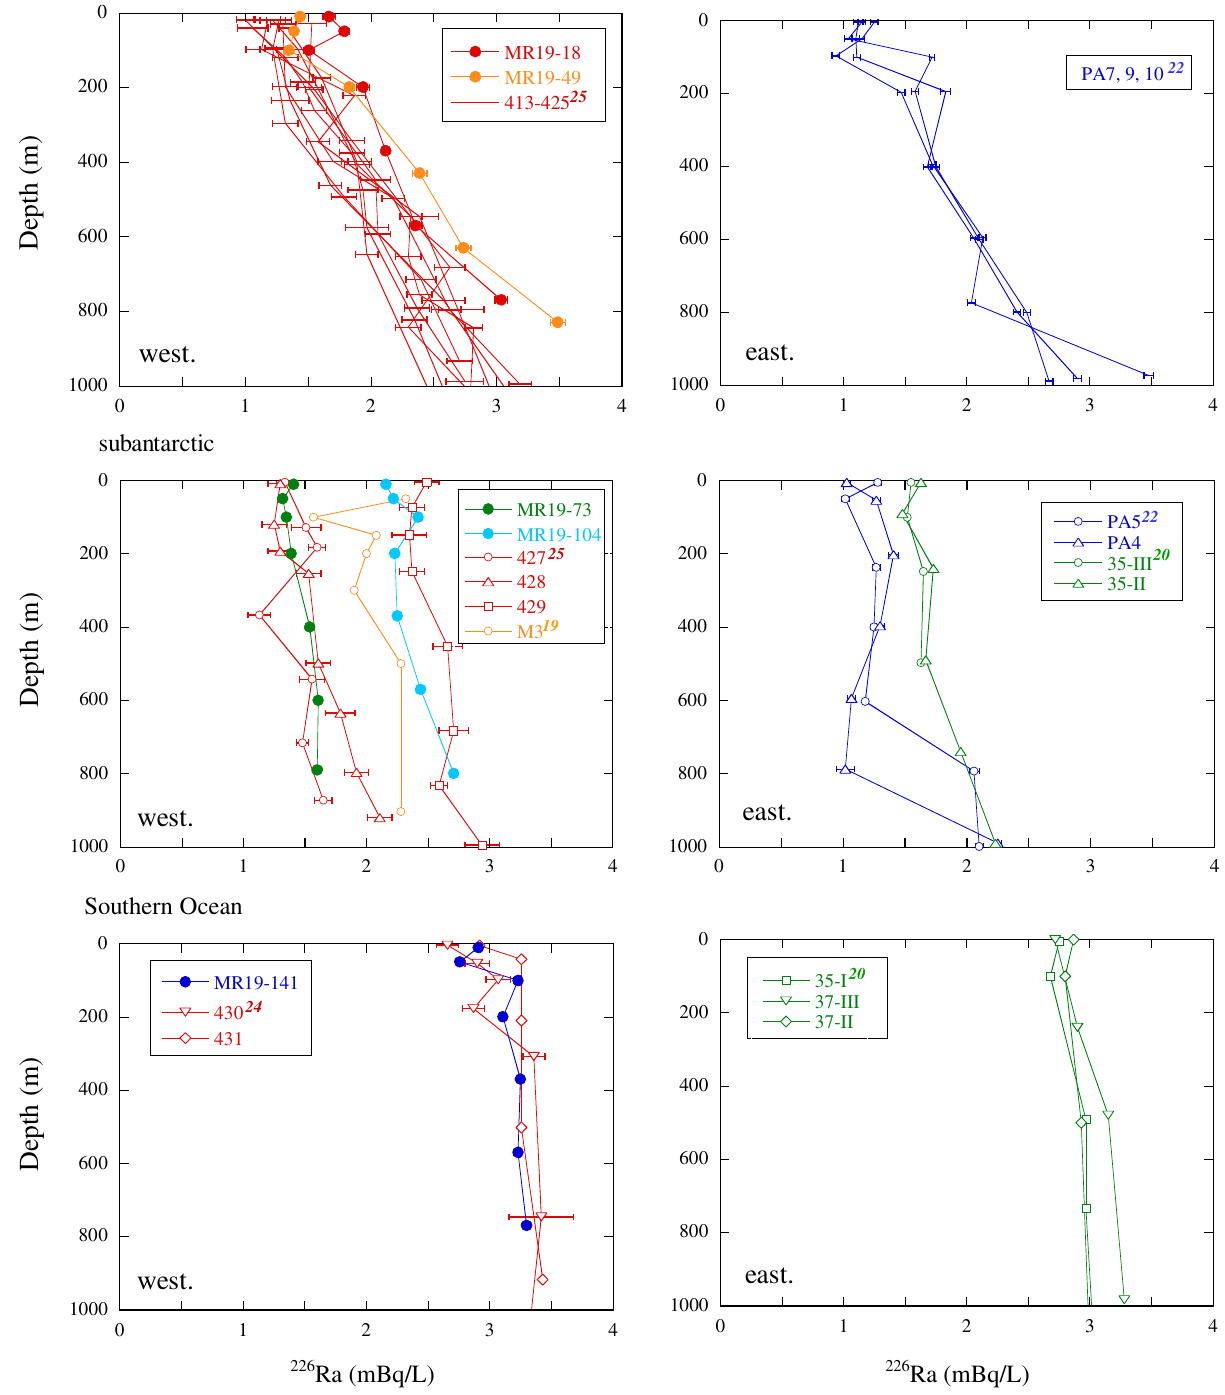
Figure 3. Vertical profiles of 226 Ra concentrations in the western (west.; < 90° E) and eastern sections (east.; > 90° E) in the monsoon–subtropical (northern side of ~ 20° S) and subantarctic (20–60° S) areas in the Indian Ocean and the Southern Ocean (southern side of ~ 60° S), along with data from previous studies in each area 19,20,22,24,25